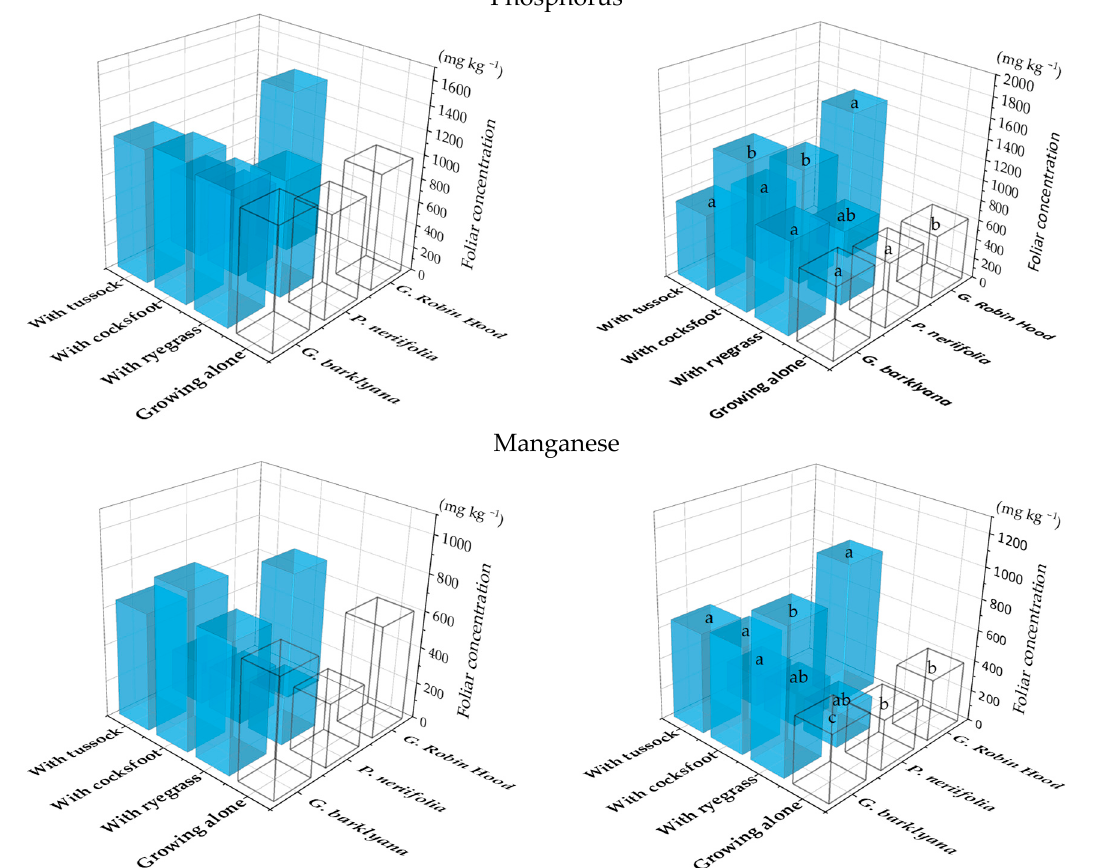
Figure 1. Phosphorus and manganese concentrations in the foliage of the three species of proteas when they were growing alone (open bars) or with one of three species of grass: Lolium perenne (ryegrass), Dactylis glomerata (cocksfoot), or Poa cita (tussock grass) (coloured bars). Charts show results of 1st (LHS) and 2nd (RHS) sampling. Different letters each indicate significant differences ( p < 0.05) for each protea (full results in Appendix A, Table A1).